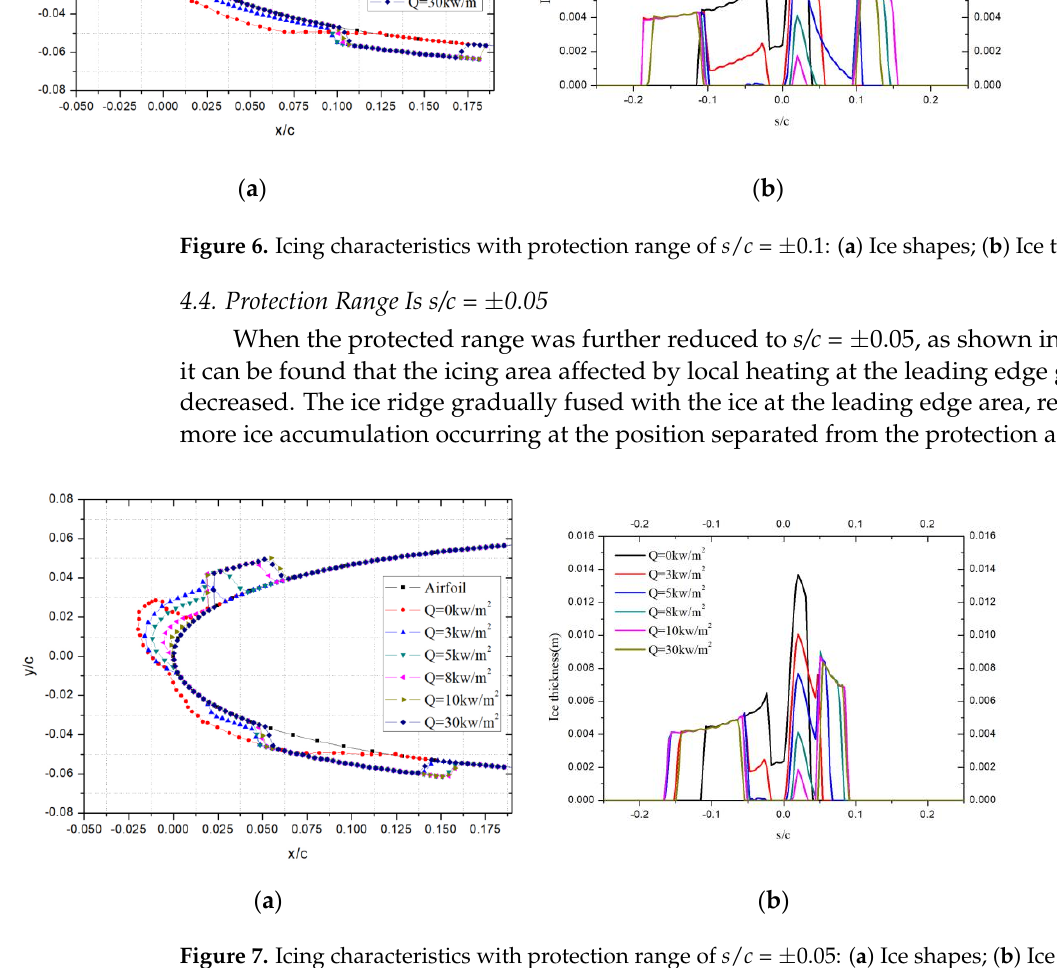
Figure 7. Icing characteristics with protection range of s / c = ± 0.05: ( a ) Ice shapes; ( b ) Ice thickness.